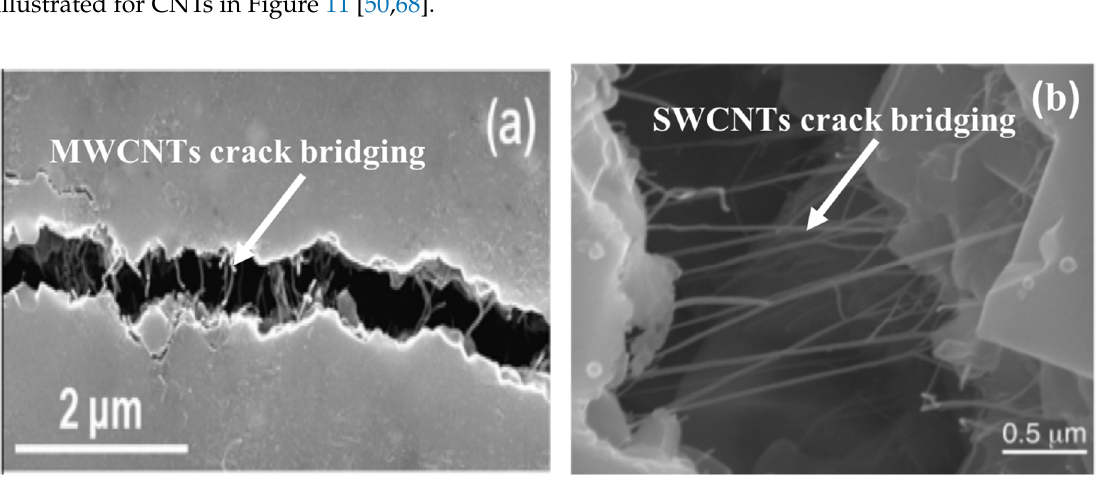
Figure 11. Crack bridging by CNTs in Si 3 N 4 + CNT systems, [50,68]. Reproduced from Refs. 50 and 68 with permission from John Wiley and Sons and Elsevier, respectively. ( a ) crack bridging by MWCNTs [68]; ( b ) crack bridging by SWCNTs [50].